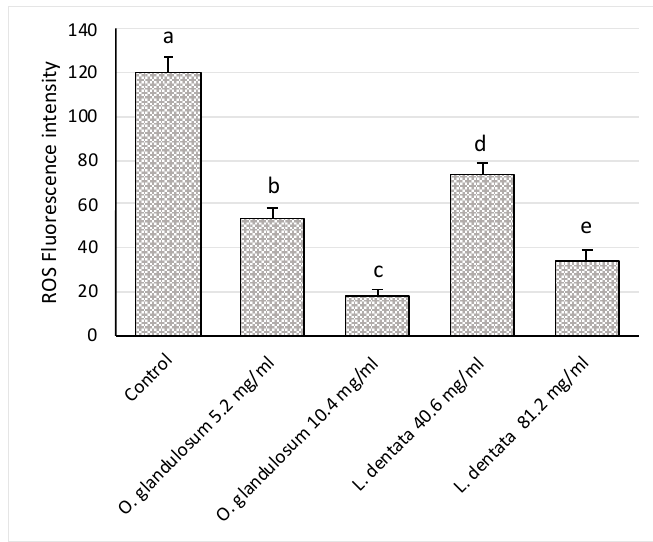
Figure 4. Effect of essential oil extracts ( O. glandulosum 5.2 and 10.4 mg/mL and L. dentata 40.6 and 81.2 mg/mL) on ROS production in polymorphonuclear neutrophils (PMN). Data were presented as mean and standard error and were analyzed with a paired t-test. Bars not accompanied by the same letter were significantly different at p < 0.05.